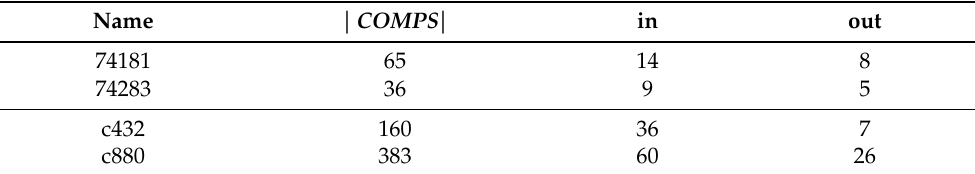
Table 2. The Benchmark suite: systems 74XXX and ISCAS-85.